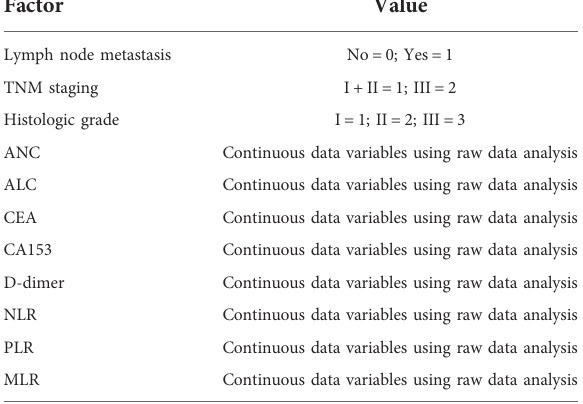
TABLE 5 Assignment.